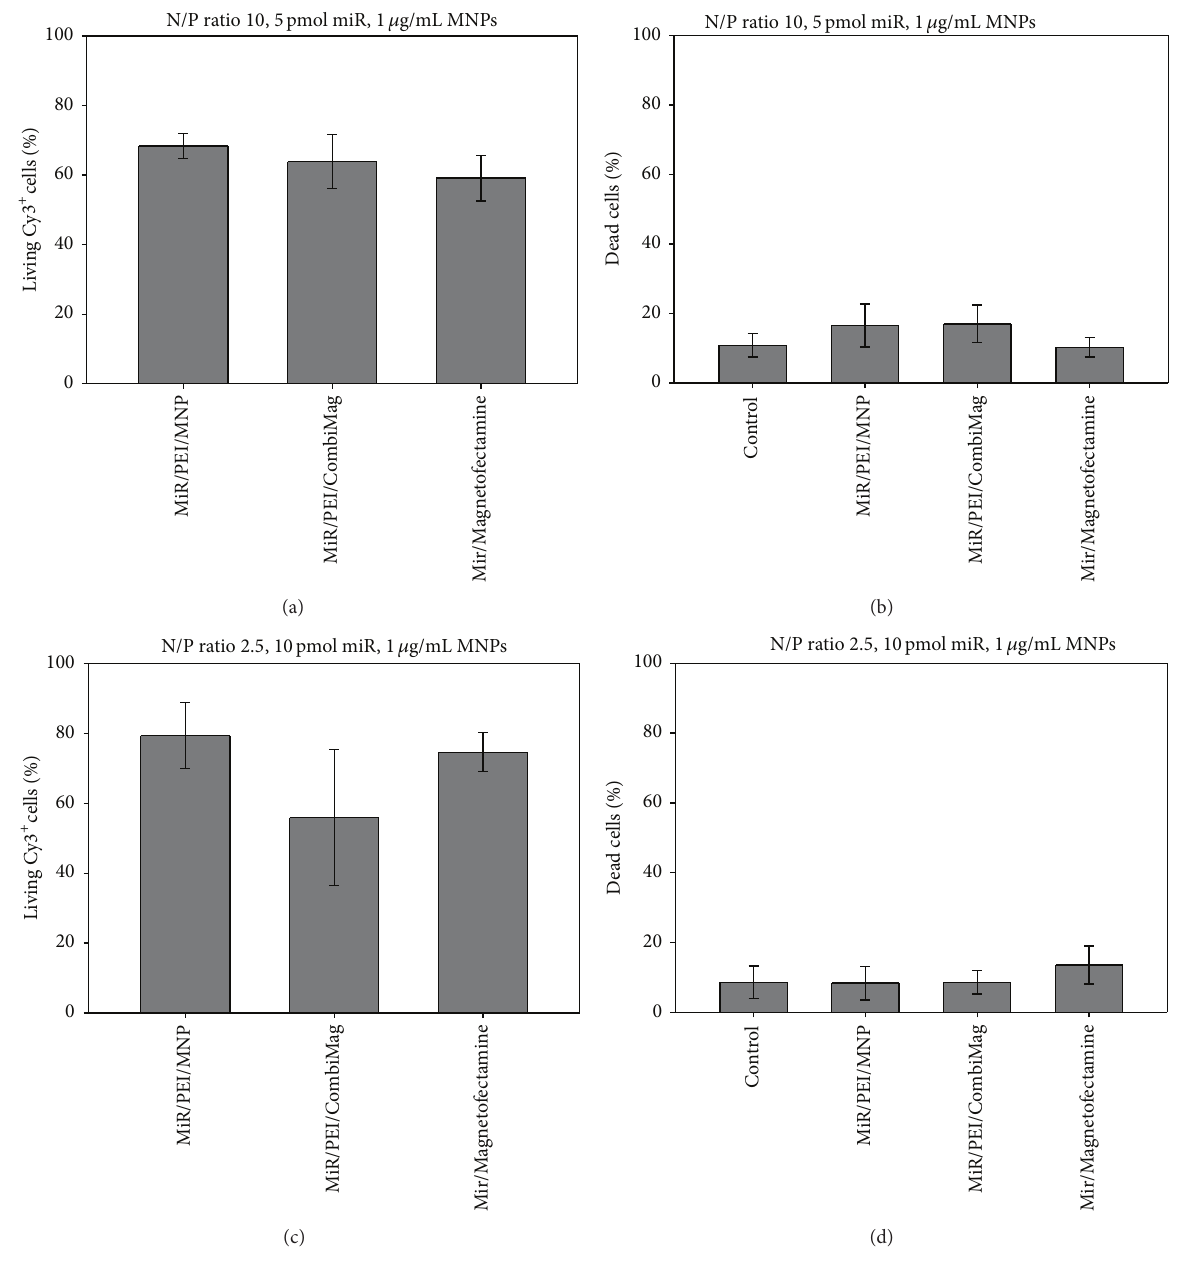
Figure 4: Comparison between optimized miR/PEI/MNP complexes and commercially available magnetic transfection reagents. Freshly isolated hMSCs were transfected with Cy3-labeled miR/PEI/MNP complexes composed of an N/P ratio of 10 combined with 5pmol miR bound to 1 𝜇 g/mL MNPs ((a), (b)) or an N/P ratio of 2.5 combined with 10pmol miR bound to 1 𝜇 g/mL MNPs ((c), (d)). For comparison with commercially available magnetic transfection complexes, appropriate amounts of Lipofectamine 2000 and CombiMag particles were used. 24 hours after transfection, uptake efficiency ((a), (c)) and cytotoxicity ((b), (d)) of complexes were determined by flow cytometry, while a magnetic field was applied. Untransfected cells were used as control. Values are presented as mean ± SEM; 𝑛 = 3 . amounts (5 and 10 pmol) were tested (Figures 2(c) and